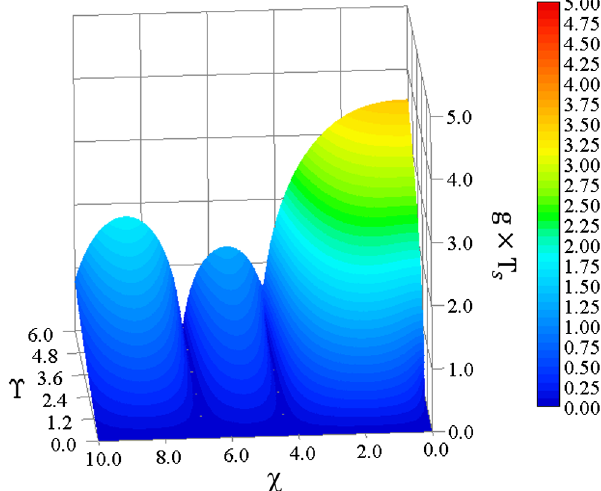
FIG. 10. Three-dimensional contour plot for the growth factor g × T as a function of ϒ and χ from an angle different from Fig. s